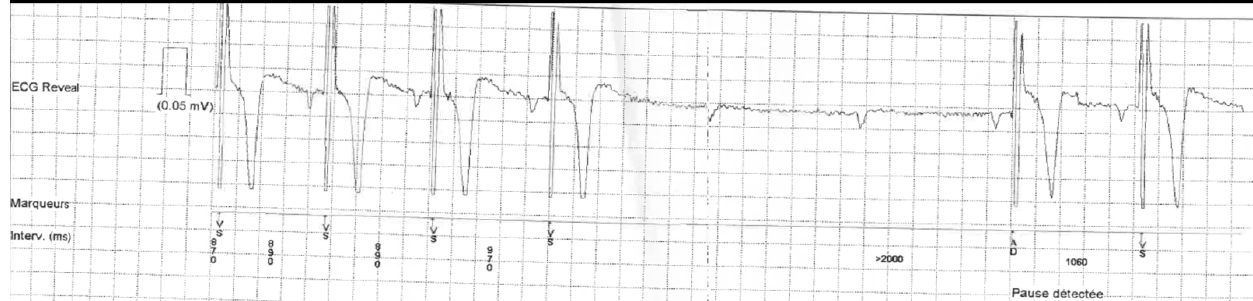
Figure 1. Example of patient presenting with vagally-mediated complete AVB recorded with an implantable loop recorder. One can notice the gradual PP lengthening before the occurrence of complete AVB, but also during the absence of the QRS complexes. A PR interval prolongation is also visible before AVB occurred, with the PR interval after resolution of the block slightly longer than PR before the block. This type of AVB mechanism was excluded from the study. AVB: atrioventricular block.